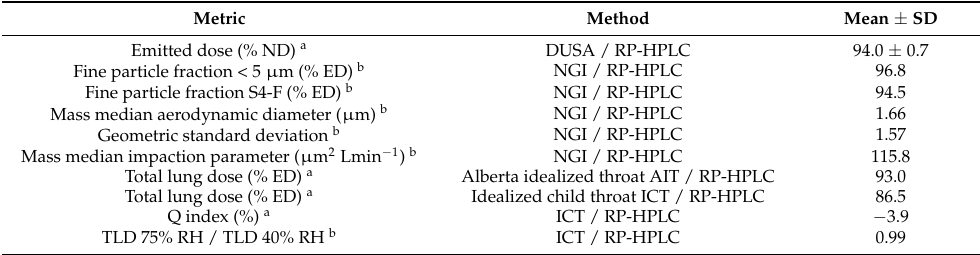
Table 2. Aerosol performance metrics for